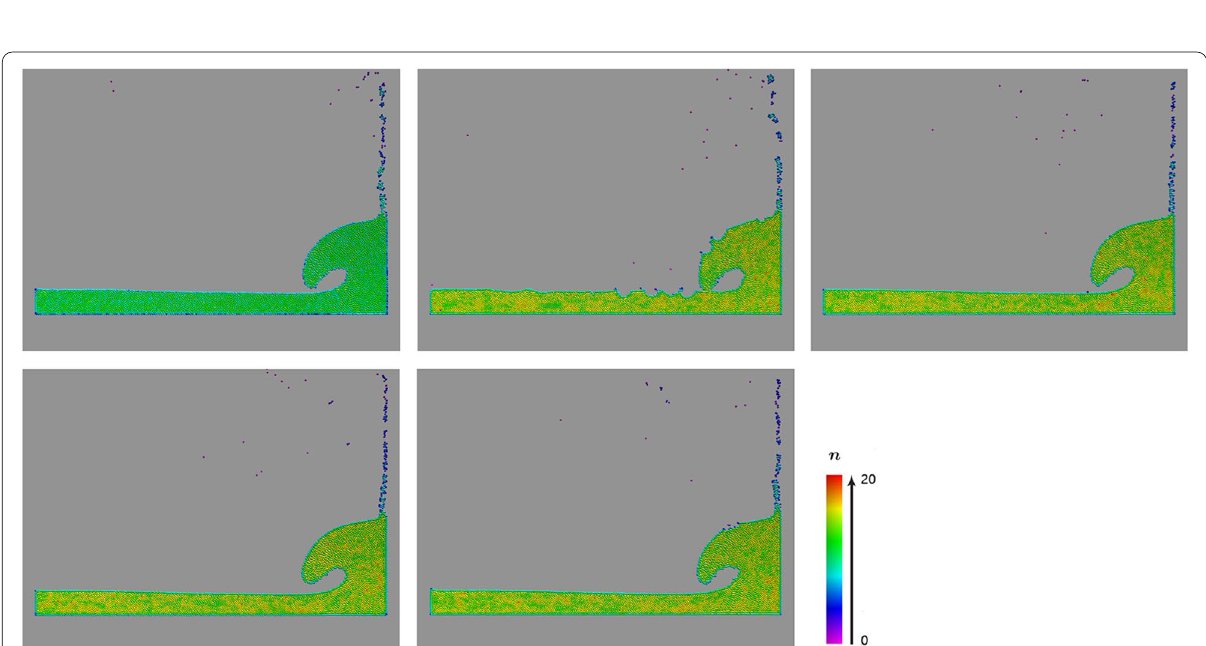
Fig. 3 Simulations of a 2D dam-break scene (5476 particles) using different methods, where the number of neighbors per particle is shown by different colors, ranging from purple to red. Top: VSLSPH (the proposed method), WCSPH [14], and PCISPH [7]. Bottom: IISPH [8] and DFSPH [9,